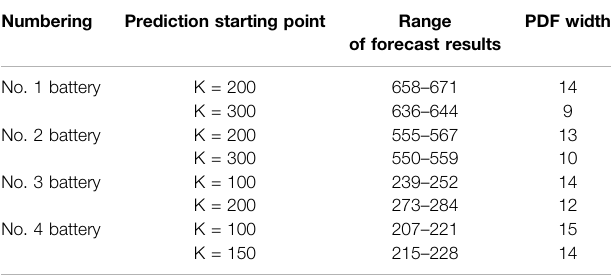
TABLE 5 | Predicted probability distribution of batteries 1 – 4 by the improved particle fi lter algorithm.